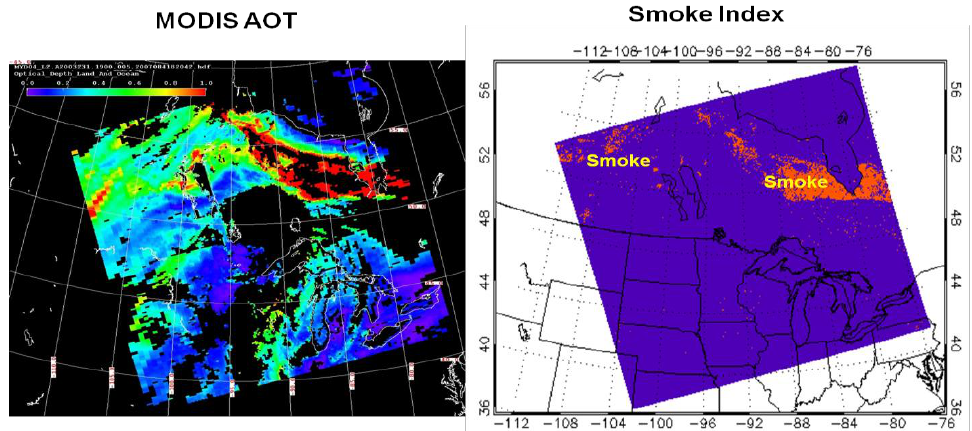
Figure 22. Left: Aqua MODIS AOT on August 19, 2003 at about 19:00 UTC. Right: the results of the smoke detection (pixels flagged as smoky are in